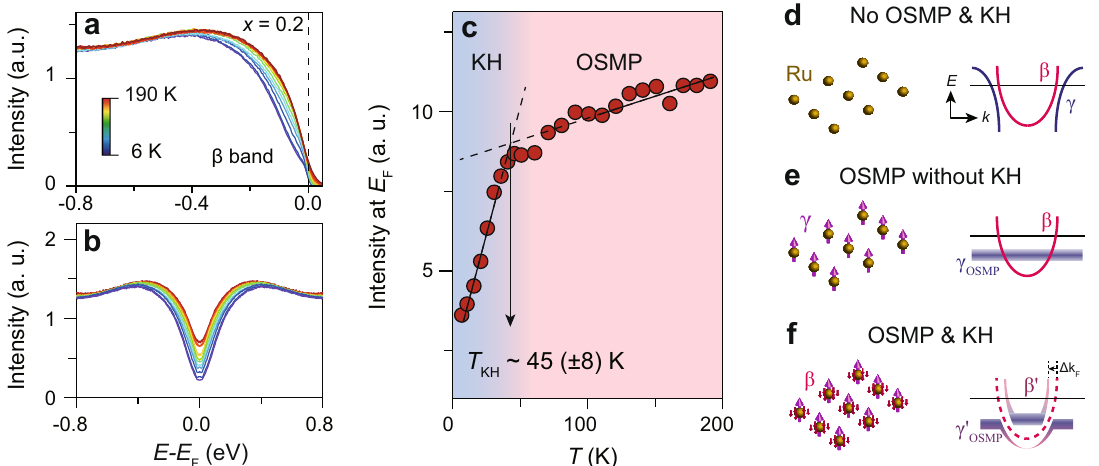
Fig. 5 Determination of Kondo-hybridisation (KH) temperature ( T KH ) and evolution of KH with OSMP among the 4 d t 2g orbitals. T -dependent EDCs ( a ) and their symmetrized form ( b ) of x = 0.2 integrated over the 0.4 ≤ k x ≤ 0.5 region (around the β -band, region #2 in Supplementary Fig. 2e). The raw ARPES data are also shown in Supplementary Fig. 2e. c Near E F spectral weight ( Δ E = ± 20 meV) of the symmetrized EDCs in b as a function of T . T KH is determined to be 45 (±8) K. Schematics of the spin structure and corresponding electronic structure of the β - and γ -bands in three different cases: d without OSMP and KH, e with OSMP but without KH and f with both OSMP and